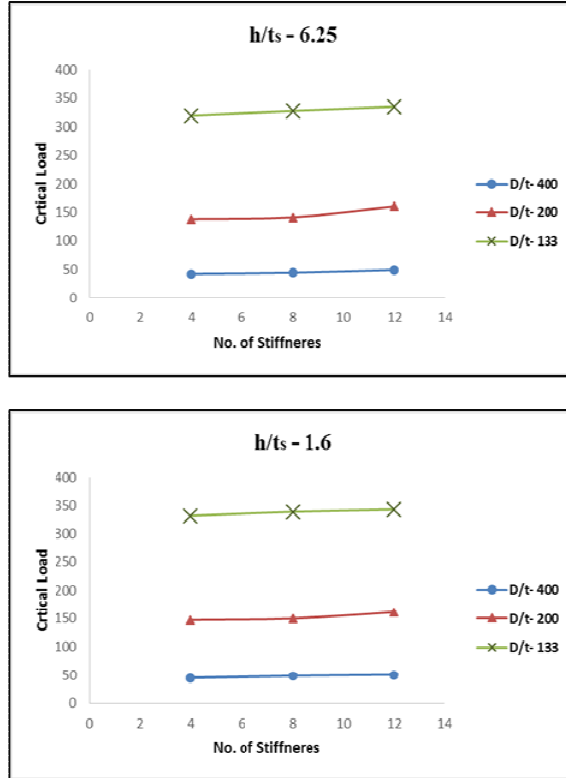
Fig. 5. The variation of critical load with parameters at constant h/ts ratio